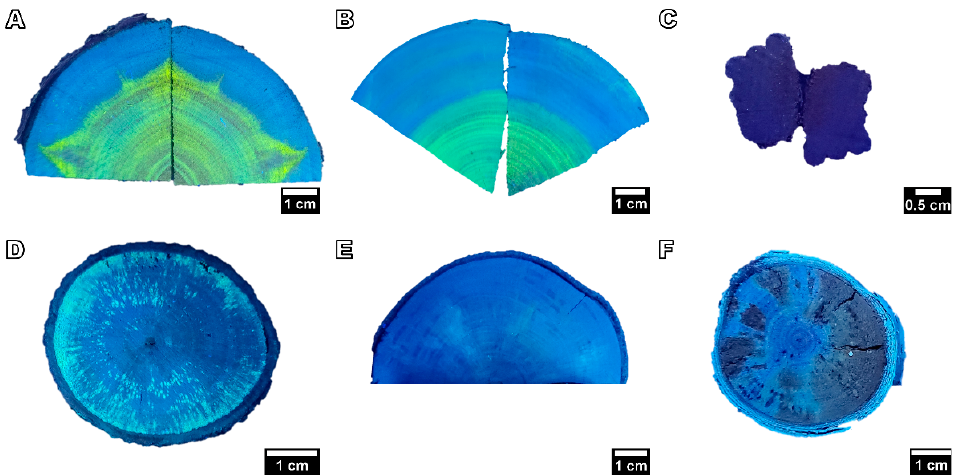
Figure 7. Heartwood fluorescence of Acacia mangium ( A ), Acacia hybrid ( B ), Dillenia pentagyna ( C ), Anacardium occidentale ( D ), Hevea brasiliensis ( E ), and Melaleuca cajuputi ( F ). Disks ( A , B , D – F ) and chips ( C ).